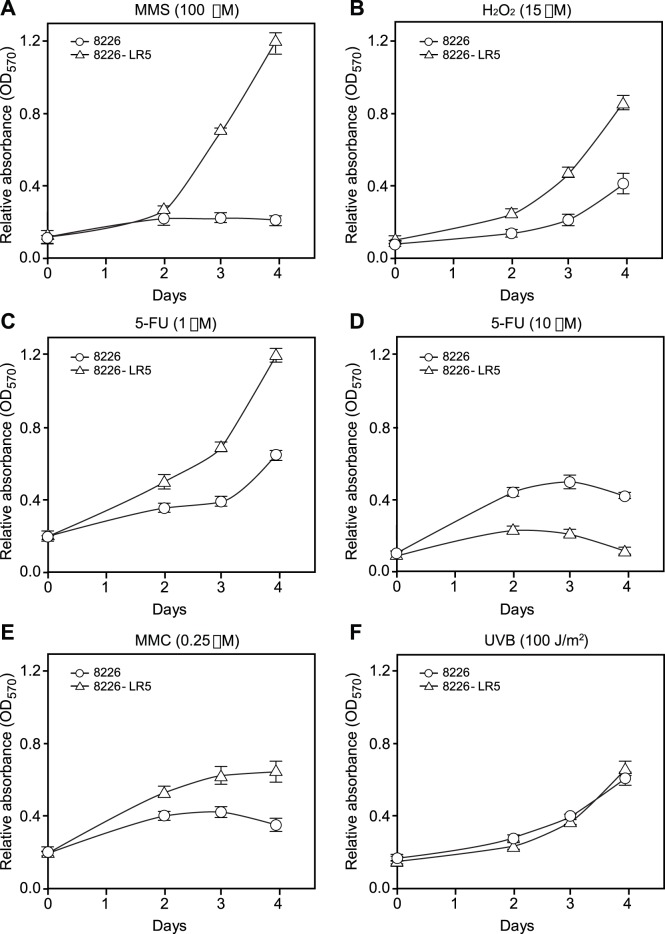
Melphalan resistance is accompanied by increased resistance to agents inducing non-bulky BER substrates.Cell were exposed to MMS (A), H2O2 (B), low (C) and high (D) doses of 5-FU, MMC (E) and UVB (F) assessed by the MTT assay. Viability curves showed that the Melphalan-resistant cells are cross-resistant to MMS, H2O2, low dose 5-FU and MMC. Conversely, high dose of 5-FU affects the proliferation of resistant cells in higher extent compared to sensitive cells. Exposure to UVB similarly affected growth of both cell lines. Increasing absorbance correlates directly with the number of living cells. Standard deviation bars are indicated.